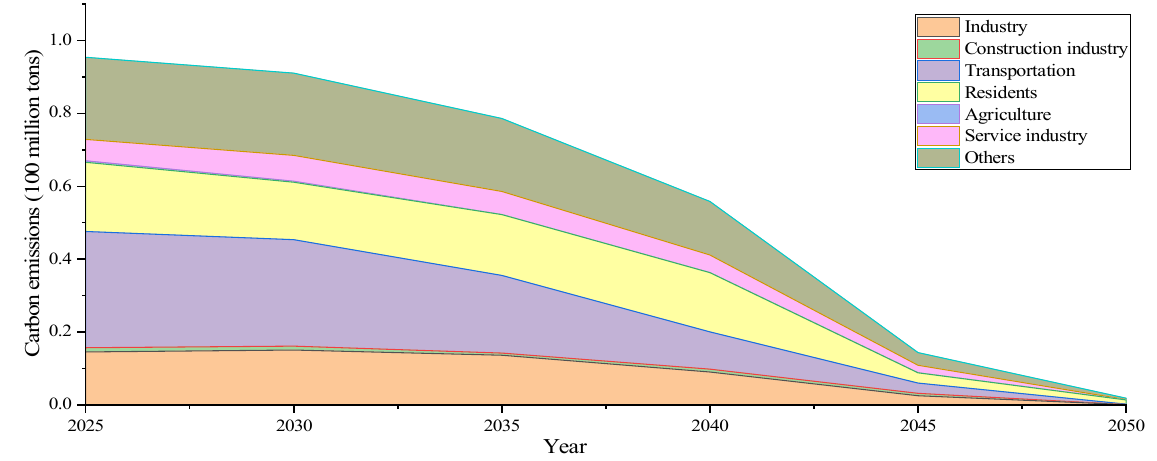
Figure 5. Summary of carbon emissions by sector under the ELC scenario.